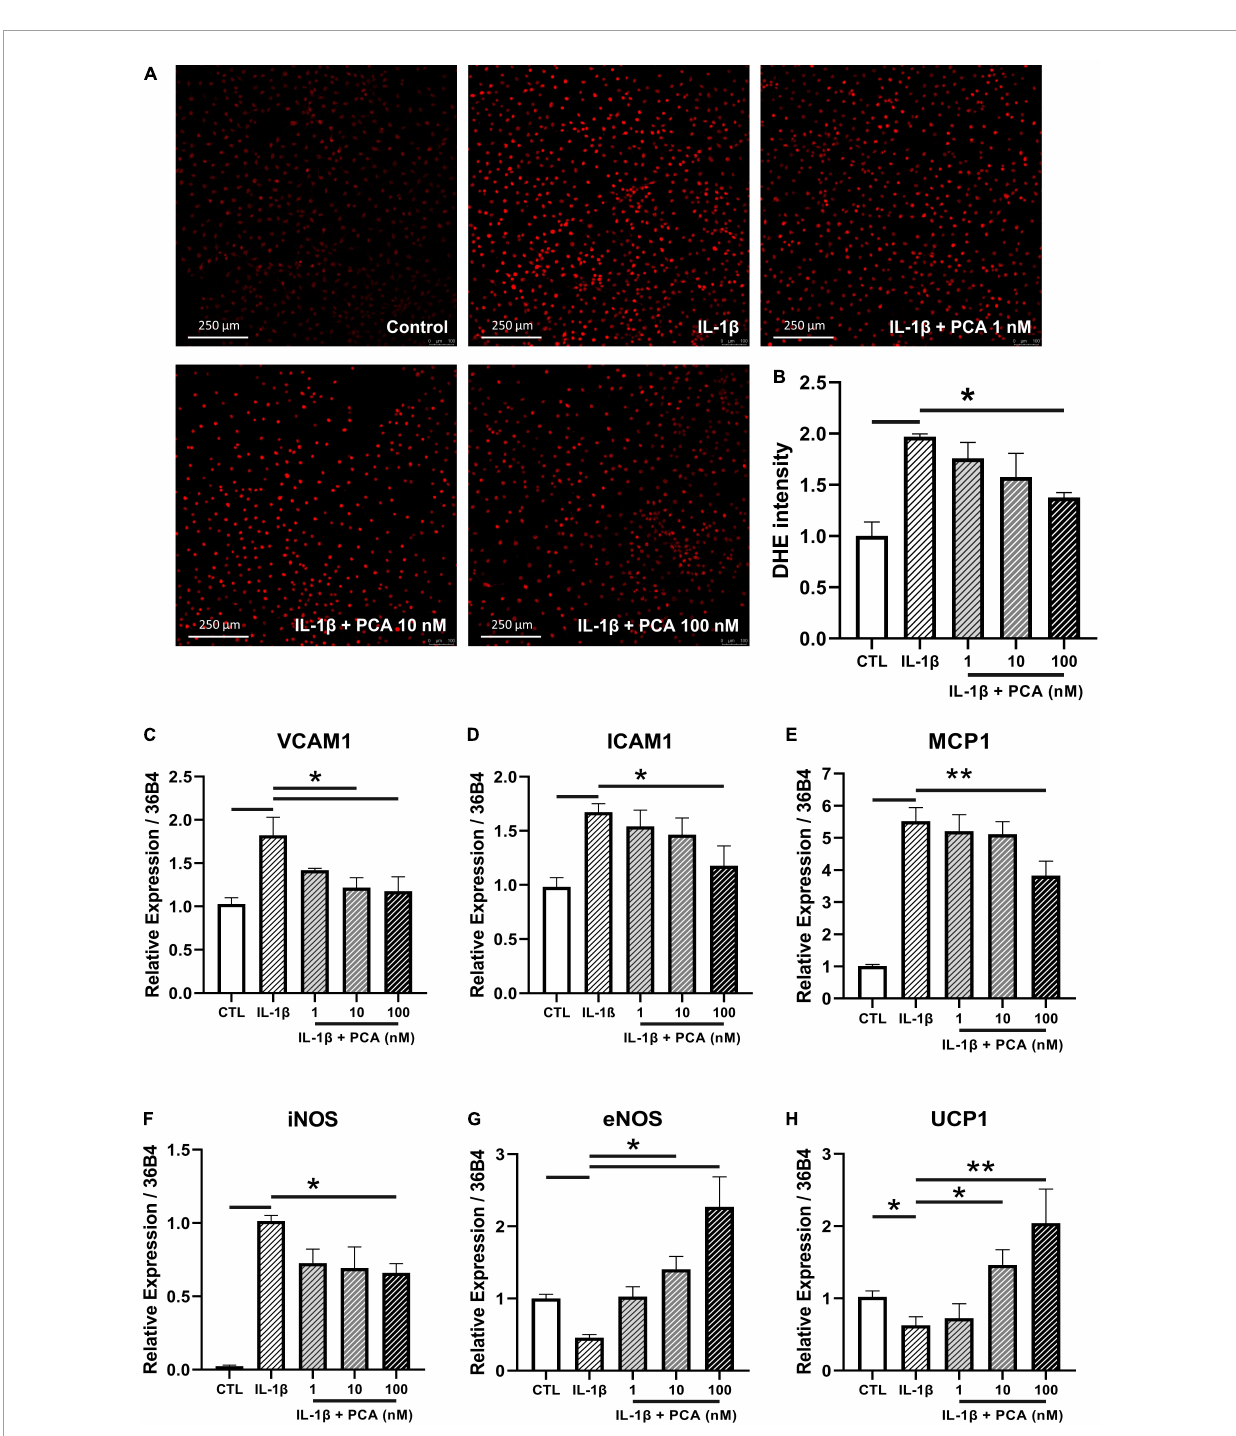
FIGURE3 PCA decreased the IL-1 β -stimulated ROS and pro-inflammatory cytokine levels in endothelial cells. Representative confocal images (A) and summarized data (B) of DHE stain intensity in mBMECs with and without PCA incubation (1-100 nM); n = 3. Summarized quantification of mRNA levels of VCAM1 (C) , ICAM1 (D) , MCP1 (E) , iNOS (F) , eNOS (G) and UCP1 (H) relative to 36B4 in mBMECs with and without IL-1 β (0.5 ng/mL) and PCA (1–100 nM) incubation; n = 6–7. Data are presented in means ± SEM; *p < 0.05, **p < 0.01. PCA, protocatechuic